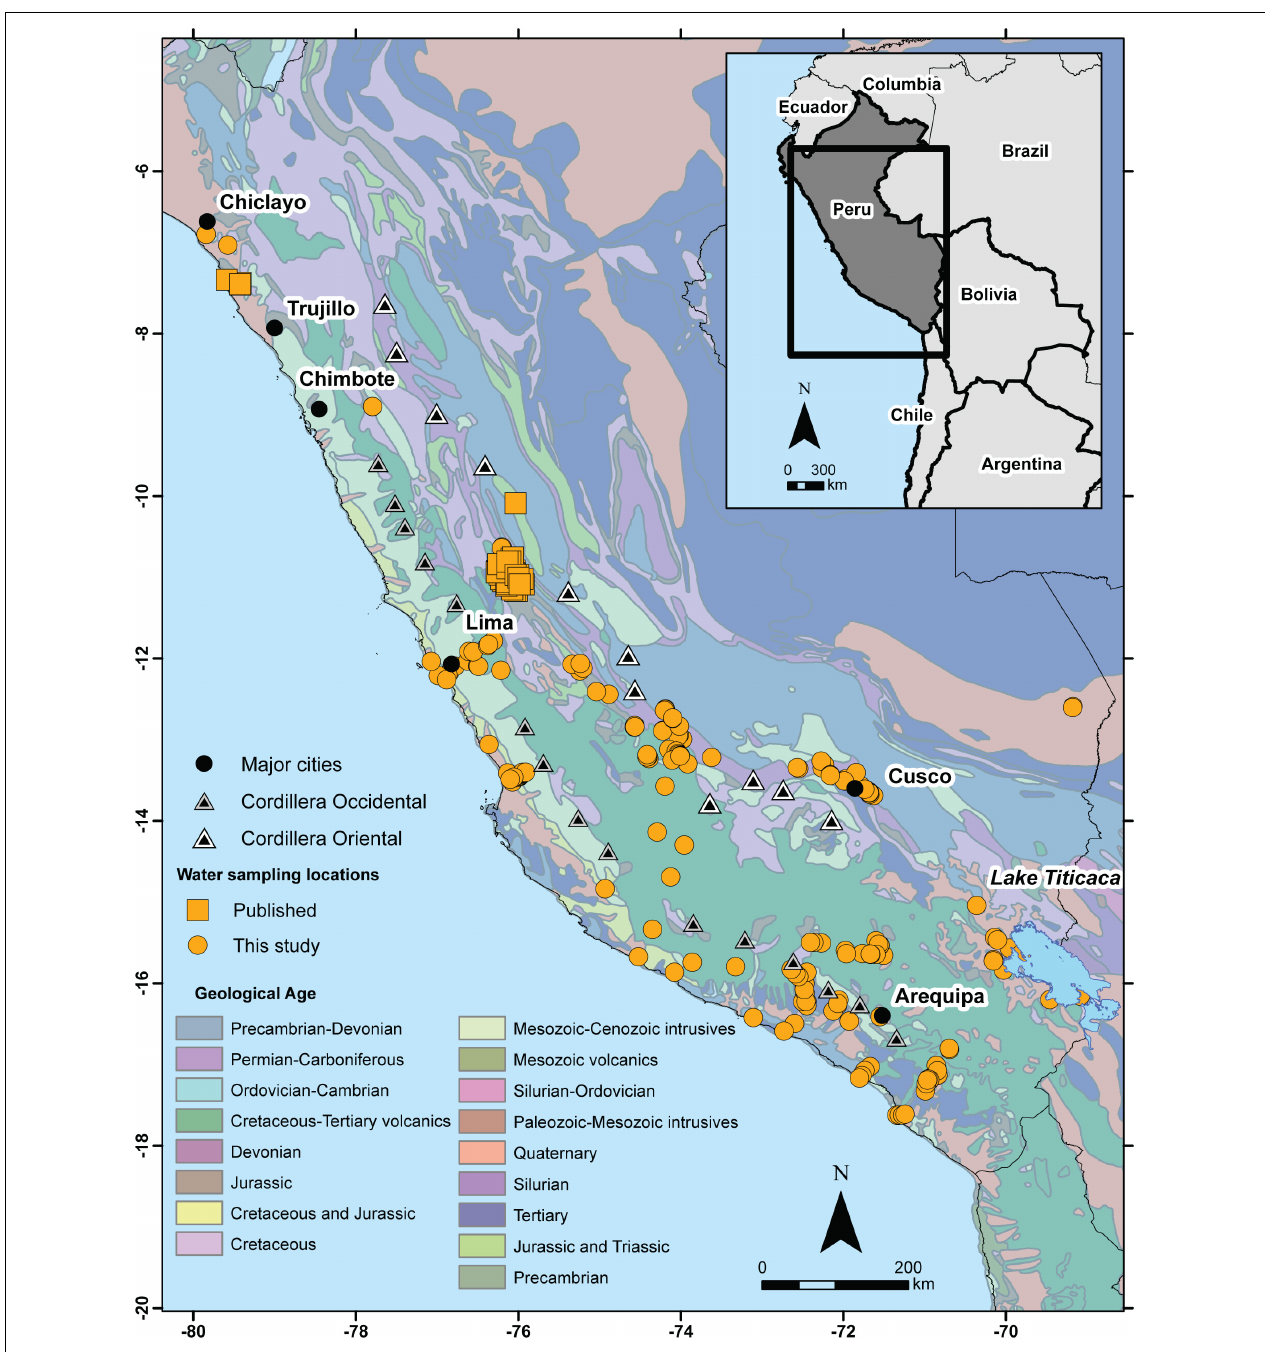
FIGURE 1 | Water sampling locations throughout Peru plotted in decimal degrees (WGS 1984 datum), relative to bedrock geology modeled by Schenk et al. (1999). Major cities and the general location of mountains in the Cordillera Occidental (Western Cordillera) and the Cordillera Oriental (Eastern Cordillera) are indicated in the